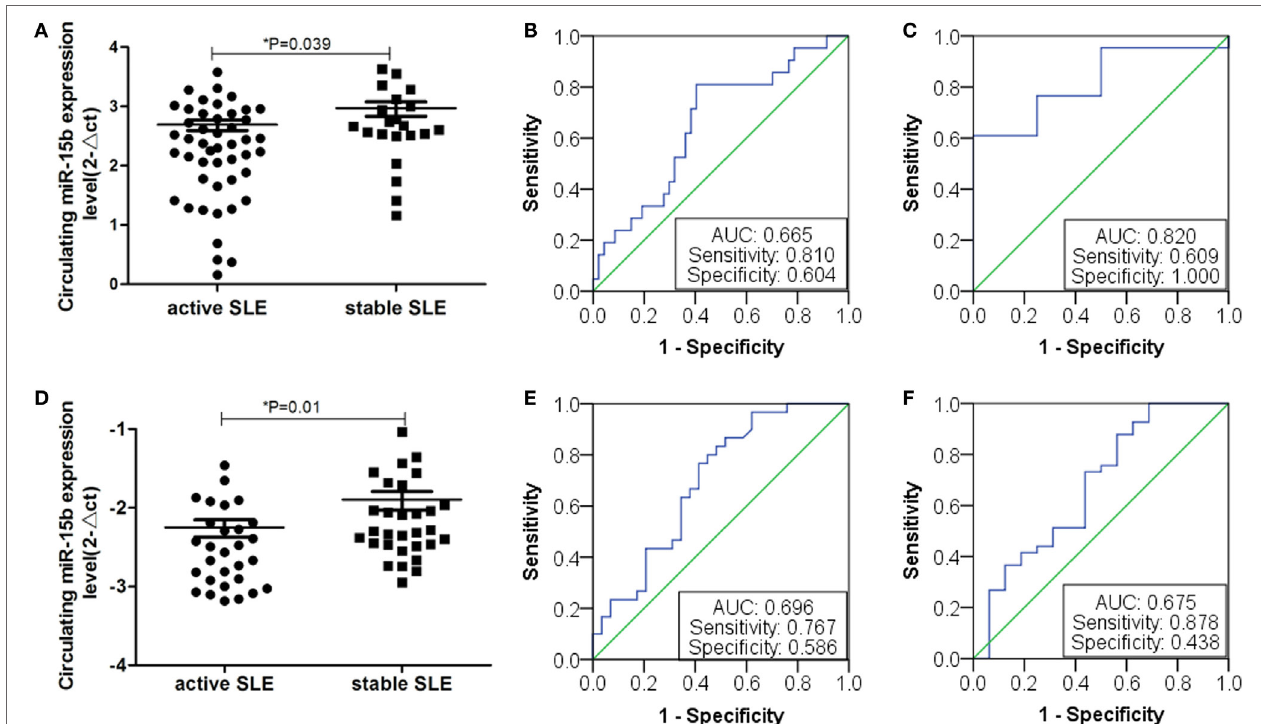
FigUre 7 | Expression of miR-15b in double validation group. (a) Plasma miR-15b expression of 69 samples from First Affiliated Hospital of Wenzhou Medical University. Plasma miR-15b was significantly different in active systemic lupus erythematosus (SLE) patients. (B) Receiver operating characteristic (ROC) curves with corresponding AUC for miR-15b in discriminating patients ( n = 69) with active SLE from stable SLE. (c) Comparison of plasma miR-15b expression level in SLE patients ( n = 69) with lupus nephritis (LN). (D) MiR-15b expressions of 80 serum samples from Ruijin Hospital of Shanghai Jiao Tong University. MiR-15b was significantly different in active SLE patients. (e) ROC curves with corresponding AUC for miR-15b in discriminating patients ( n = 80) with active SLE from stable SLE. (F) Comparison of plasma miR-15b expression level in SLE patients ( n = 69) with LN.